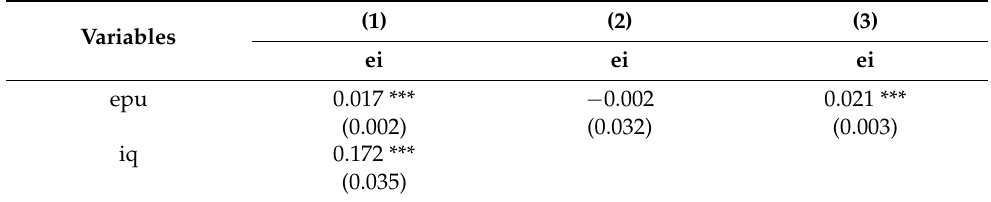
Table 10. Mechanism test